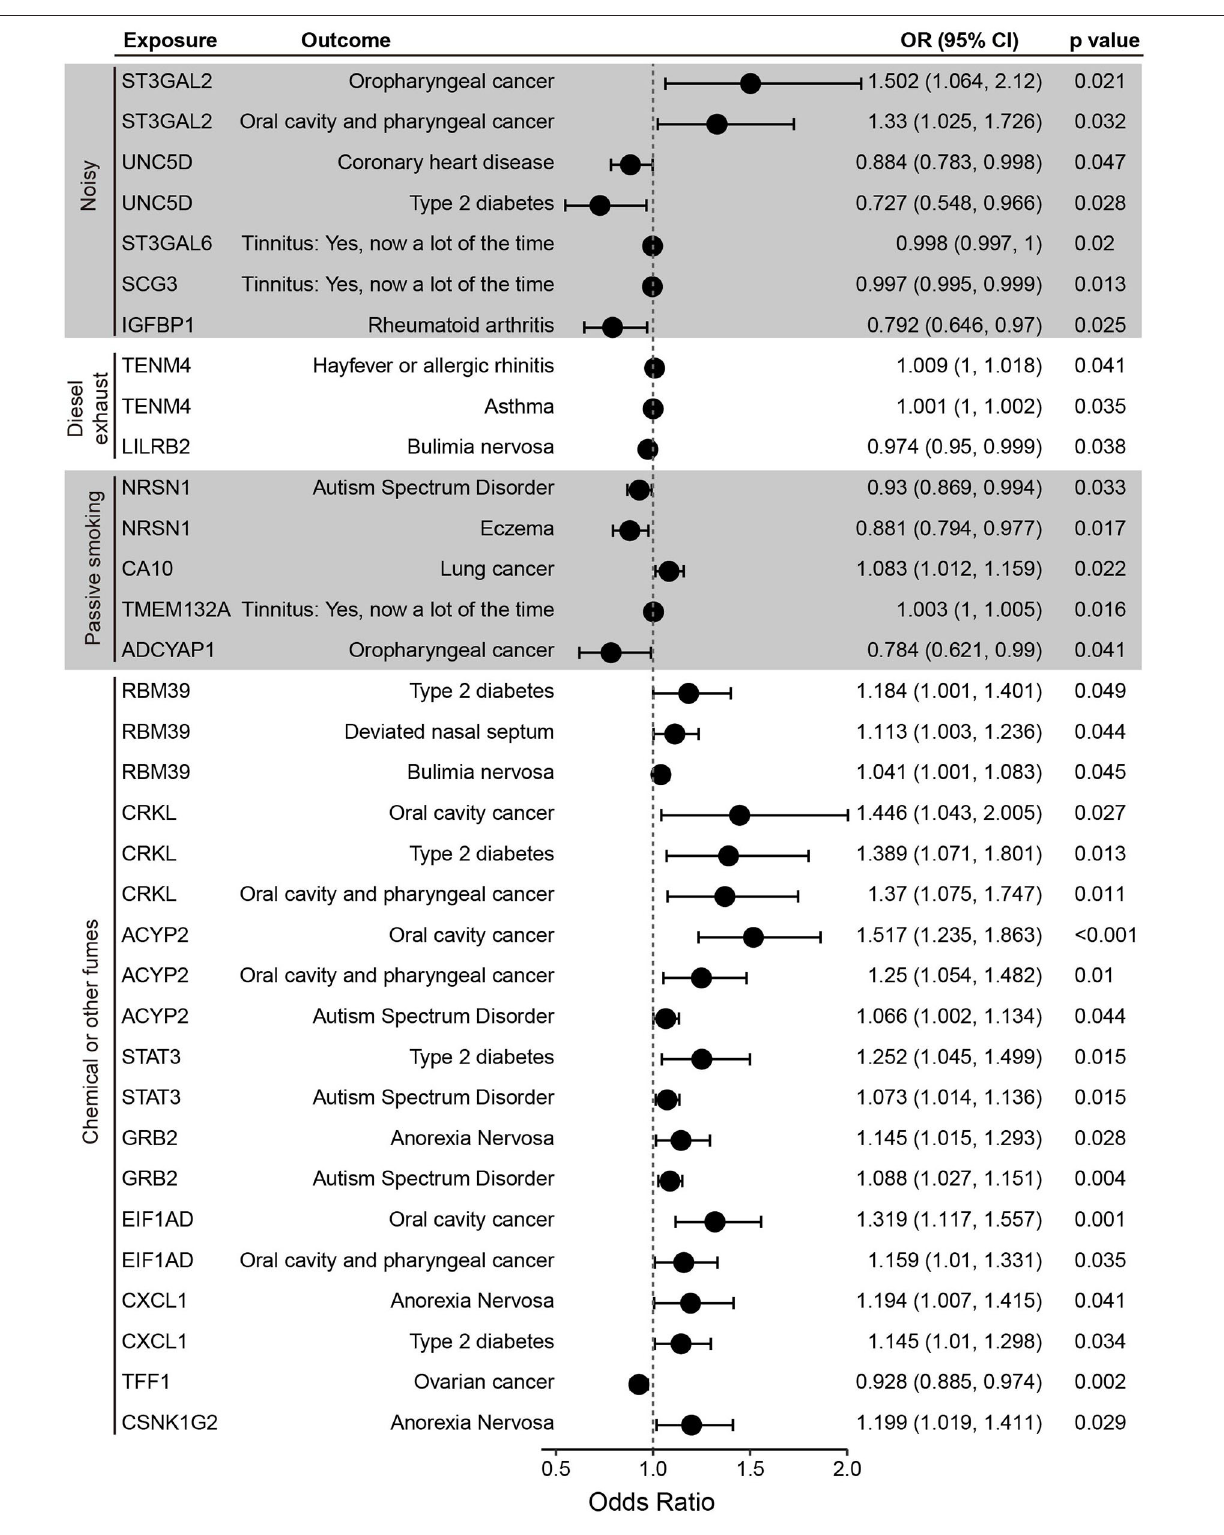
Frontiers in Public Health |